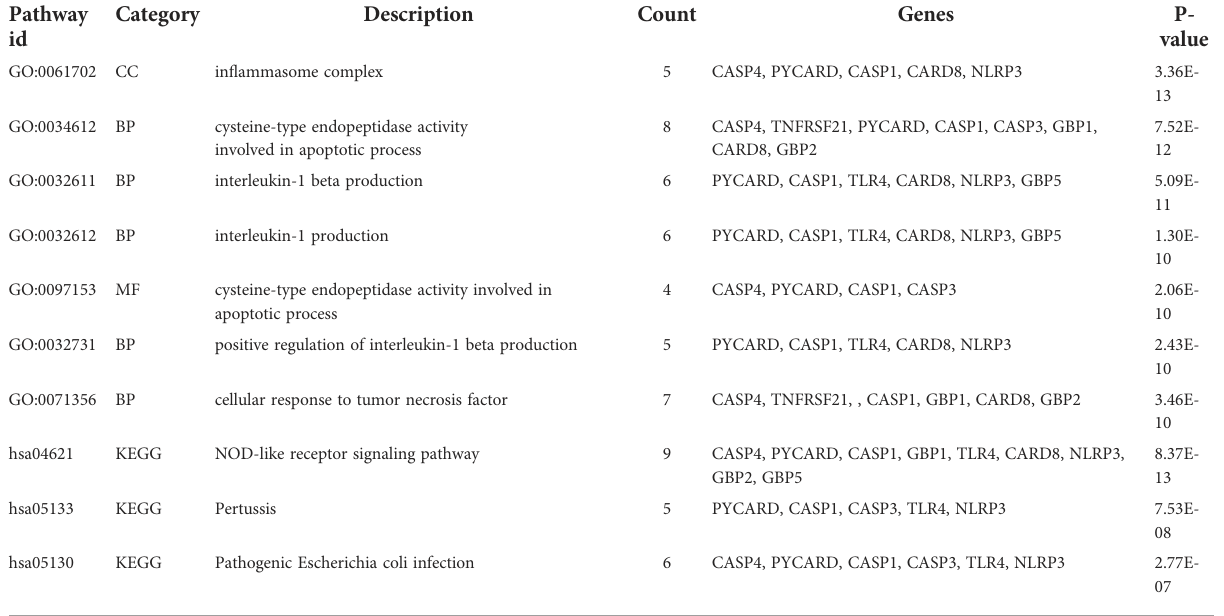
TABLE 3 Top 7 GO terms and top 3 KEGG pathway analyses for the differentially expressed PRGs. Pathway